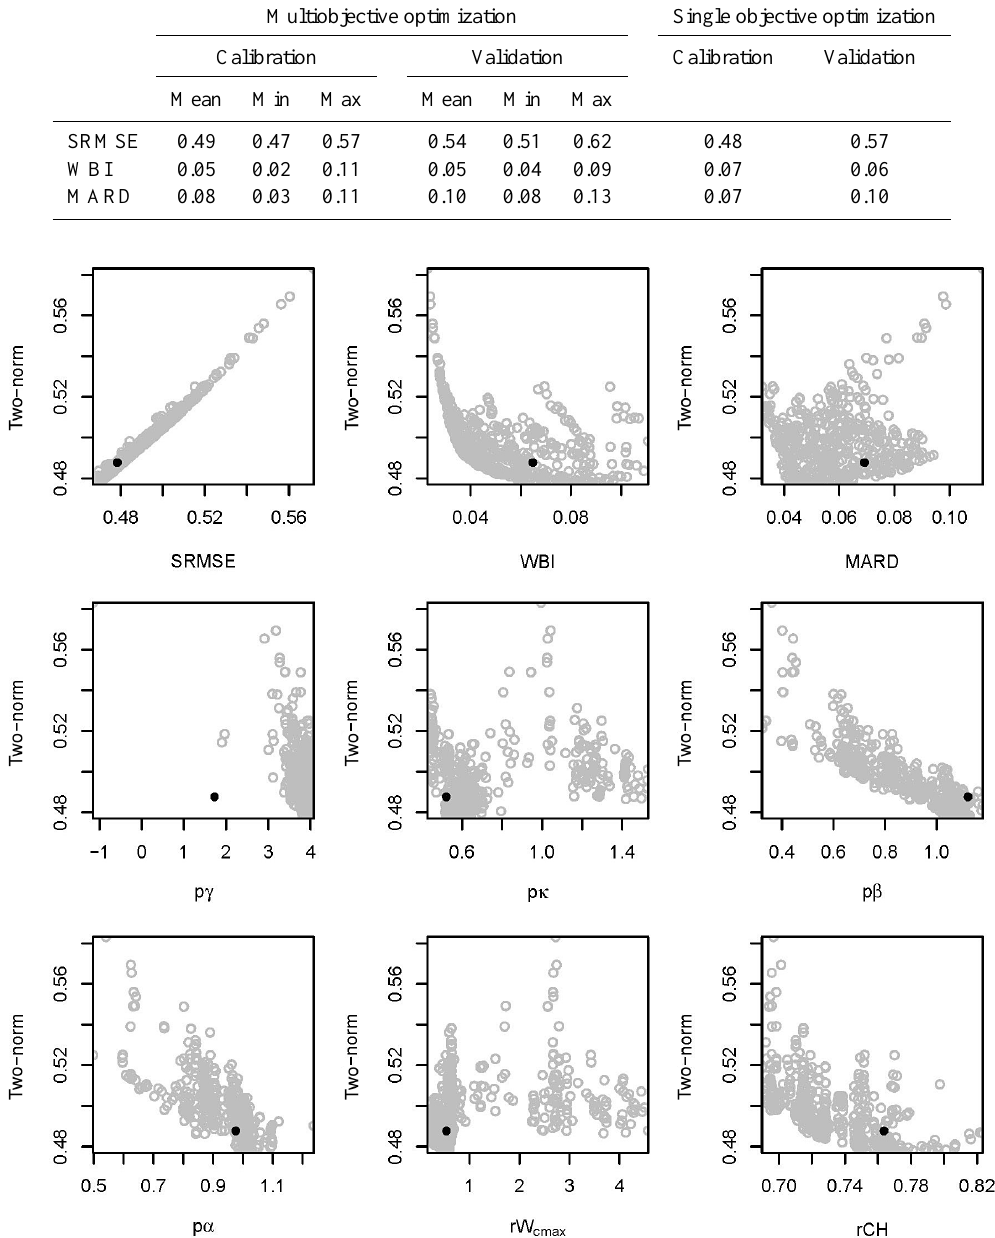
Figure 7. Two-norm level diagram representation of the Pareto sets with MOO, and the solution with SOO (black dot).